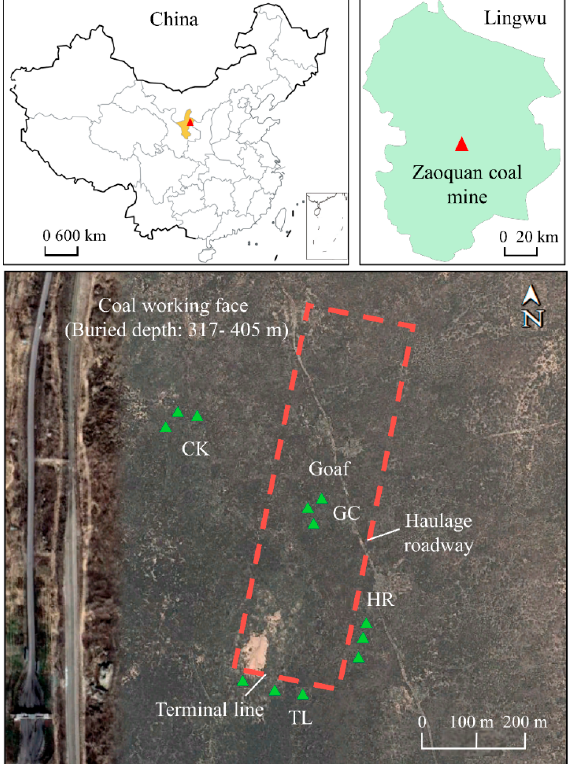
Figure 1. Map of the study site showing the sampling points in the subsidence and unmined areas. The red rectangle represents the approximate position of the working face of the underground coal mine. Each green triangle represents a single quadrat from which samples were collected.